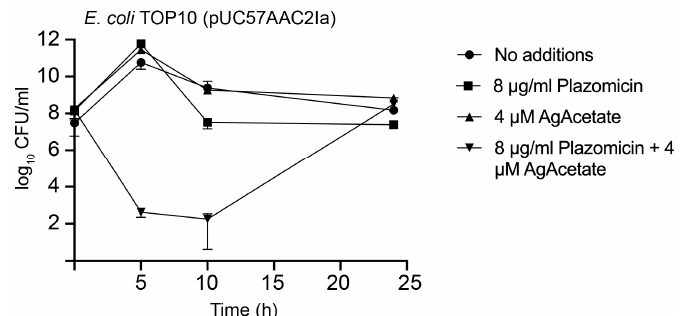
Figure 3. Time-kill assays for plazomicin in the presence of silver acetate. E. coli TOP10(pUC57AAC2Ia) was incubated at 37 °C until the cell concentration reached the CFU/mL indicated in the figure at time zero. At this moment, the culture was divided in four aliquots. An aliquot was not supplemented with any reagent. The others were each supplemented with 8 μ g/mL plazomicin, 8 μ M silver acetate, or both. The cultures were then incubated at 37 °C and the CFU/mL values were determined after the indicated periods. AgAcetate, silver acetate. Assays were done in duplicate, and the values are mean ± SD of two independent experiments.